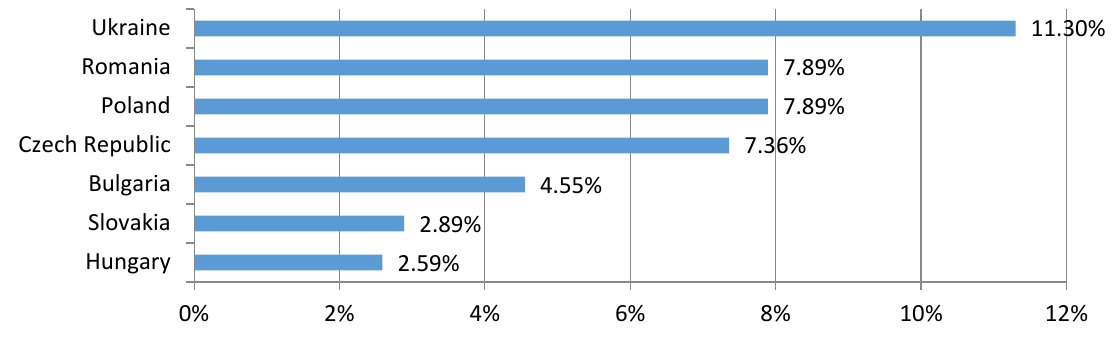
Figure 2. Variation coefficient of the integral index in Ukraine and its Western neighbors (EU members) for 2010–2016